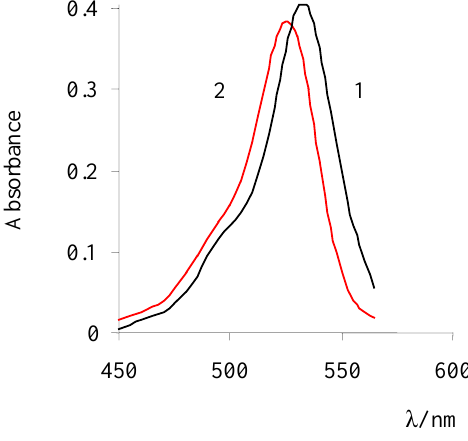
Figure 8. Absorption spectra of DODR species in aqueous CTAB solutions (0.01 M): HR + , pH = 0– ± 0.5, (1) and R , pH = 9.2